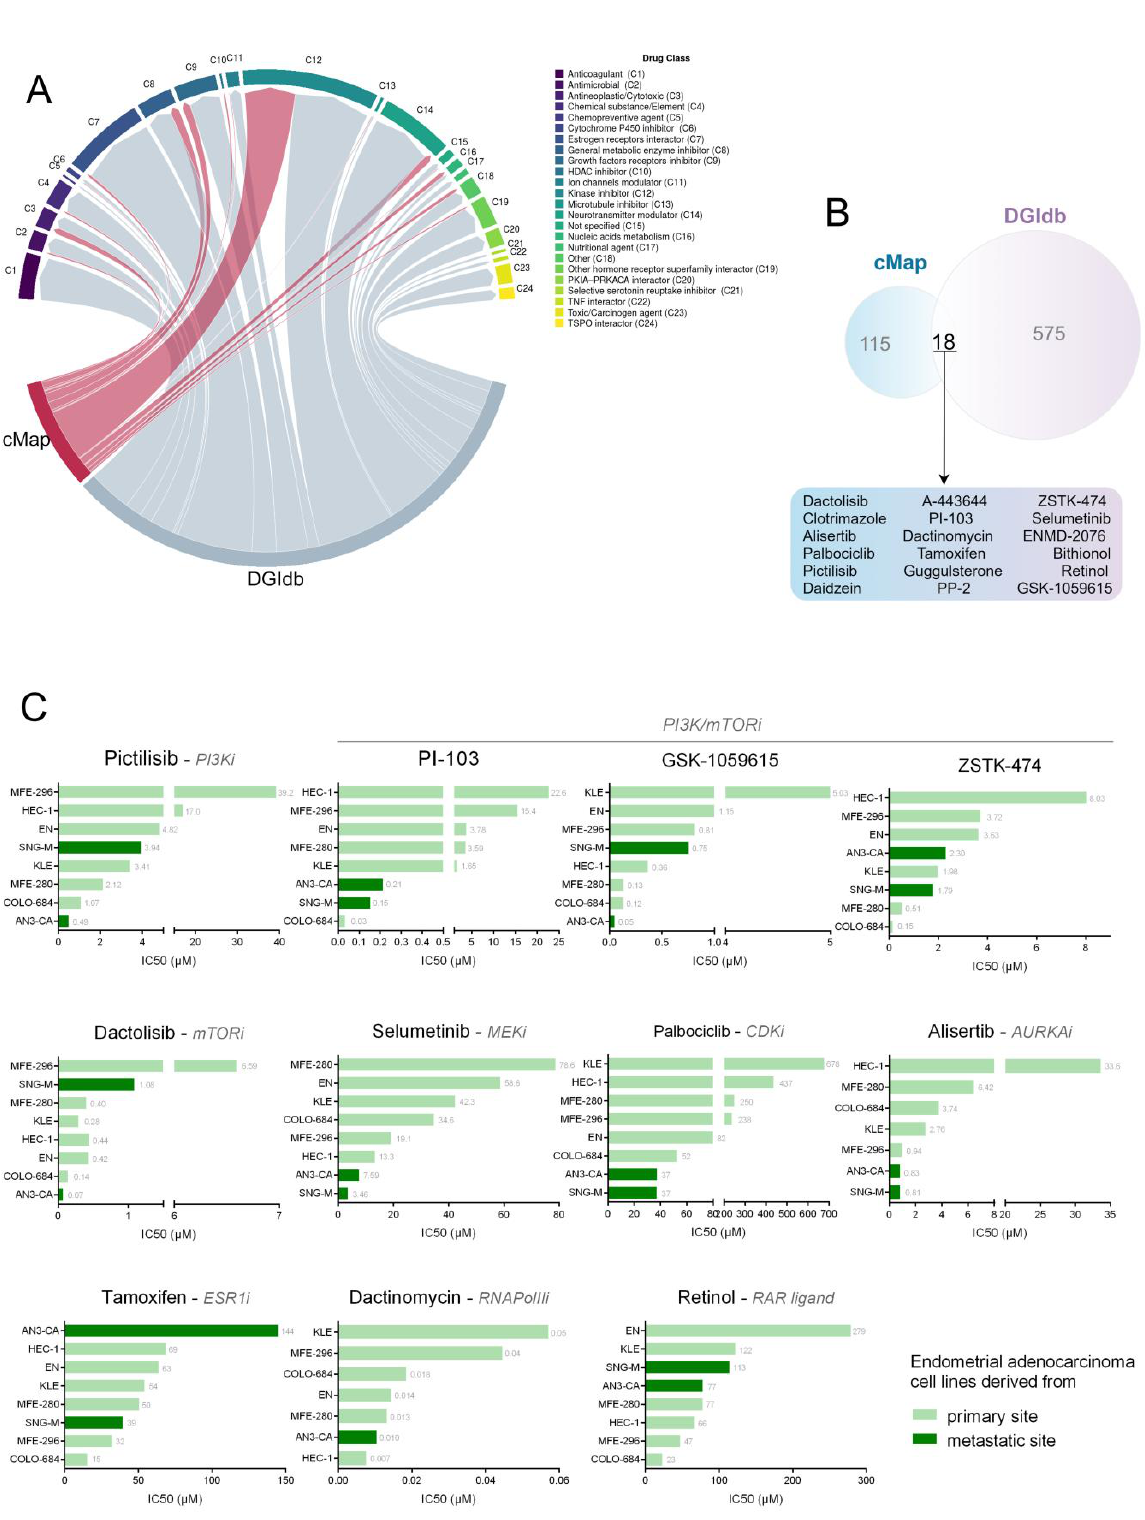
Figure 4. Validation of the efficacy of the identified drugs: ( A ) Chord plot summarizing the classifica- tion of the drug candidates obtained from the signature-matching and pathway-based repurposing approaches. Edge width is proportional to the number of drugs that belong to a certain drug class, highlighted by different colors and cited in the legend. ( B ) Venn diagram showing the molecules identified by both approaches. ( C ) Histograms showing IC50 values for each candidate drug found in the GDSC database, for EC cell lines. Next to each bar is the reported specific value of the IC50 for the corresponding cell